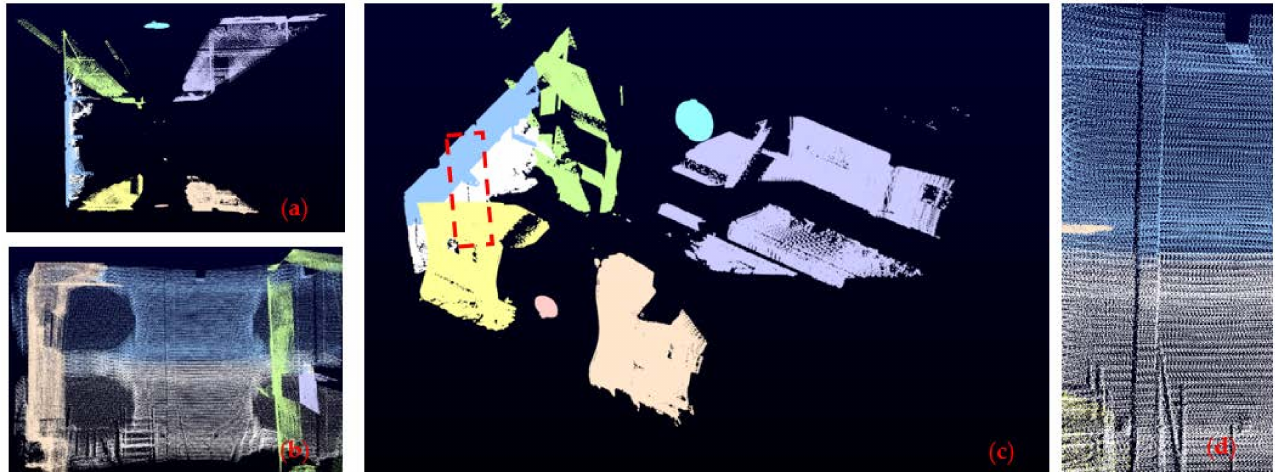
Figure 3. Visual illustration of the calibration result for the passenger vehicle platform, with eight colors representing the respective point clouds. ( a ) is from the top view, while ( b ) is from the back view, and ( c ) is a 3D overview with the zoom in of a pillar shown in ( d ). It can be noticed that the upper half and lower half of the pillar match well with each